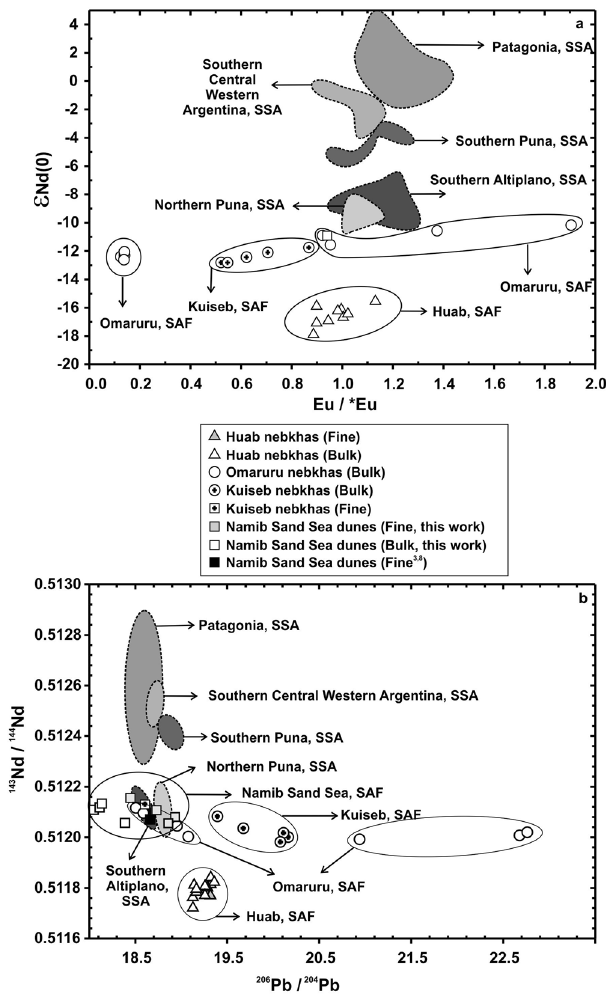
Fig. 4 Comparison of Southern Africa (SAF) with Southern South America (SSA). a Eu/ ∗ Eu vs. ε Nd(0). b 206 Pb/ 204 Pb vs. 143 Nd/ 144 Nd. SSA data from 9,10